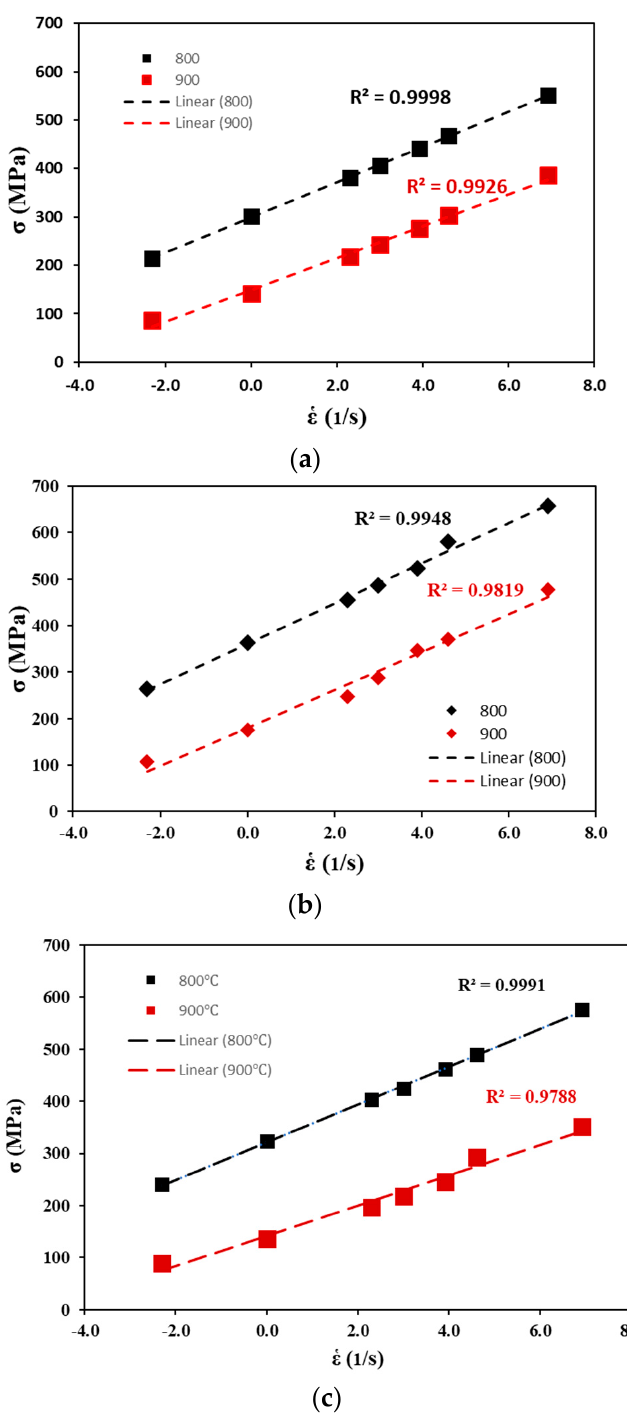
Figure 2. Peak stress obtained from the experiment and DEFORM-3D simulation ( a ) Ti-4.5Al-1V- 3Fe; ( b ) Ti-6Al-1V-3Fe; and ( c ) Ti-6Al-4V. * S represents simulated peak stress, and E represents experi- mental peak stress.